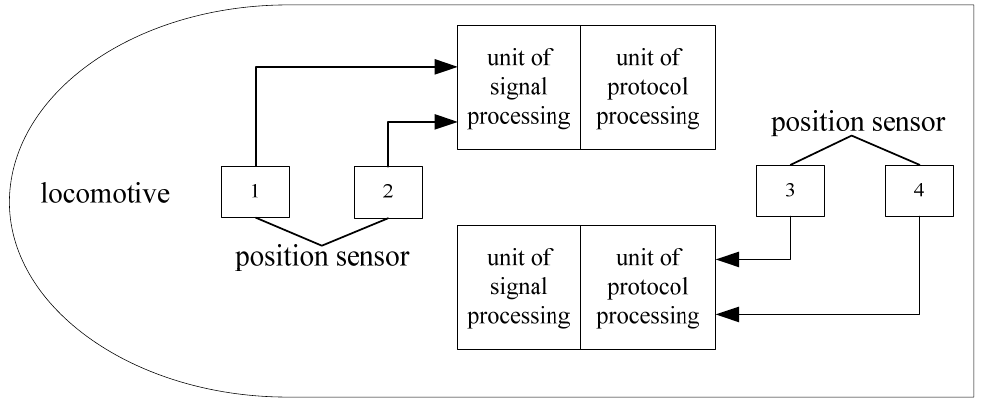
Figure 3. Structure of the speed and position detection